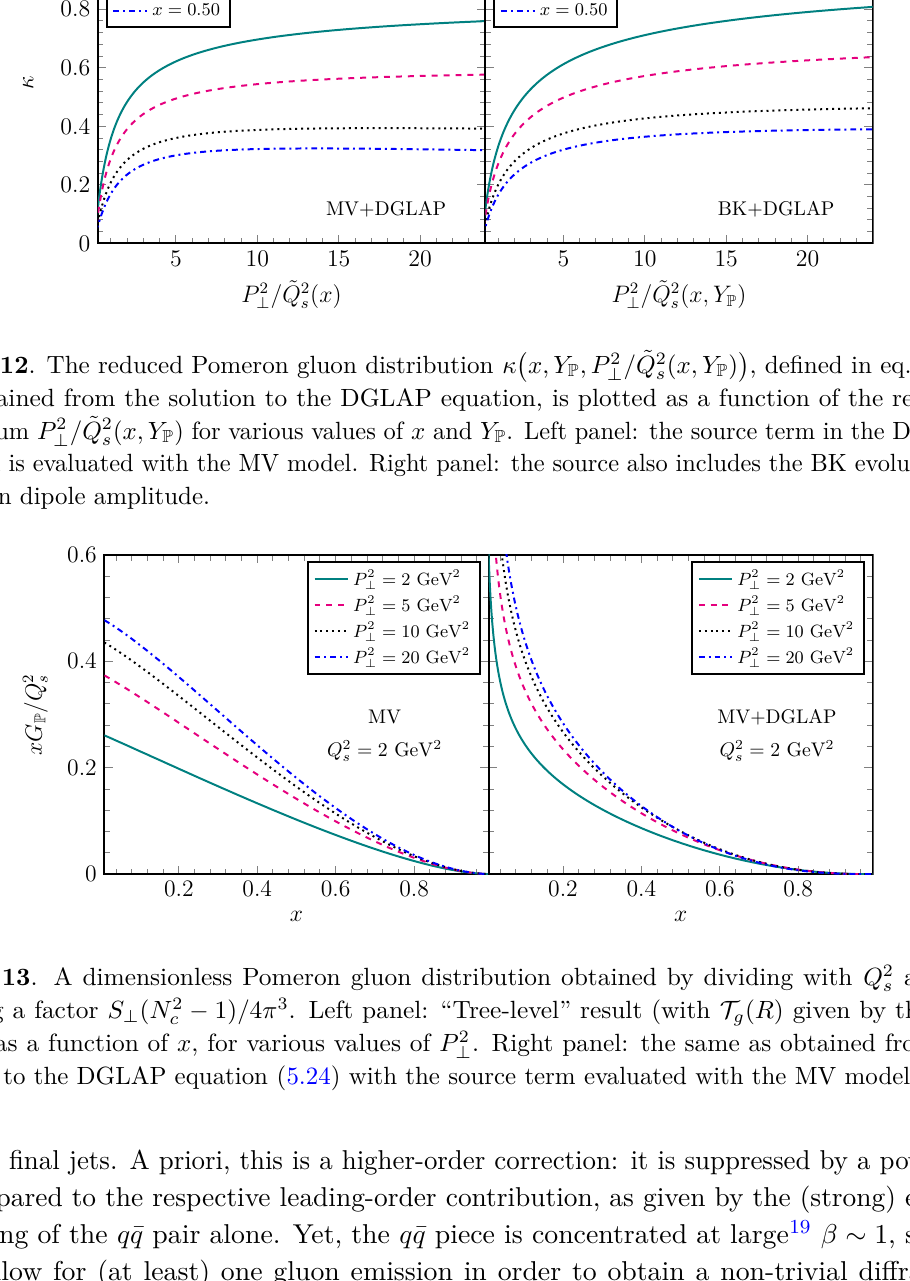
Figure 13 . A dimensionless Pomeron gluon distribution obtained by dividing with Q 2 and by s omitting a factor S ⊥ ( N 2 − 1) / 4 π 3 . Left panel: “Tree-level” result (with T g ( R ) given by the MV c model) as a function of x , for various values of P 2 . Right panel: the same as obtained from the ⊥ solution to the DGLAP equation (5.24) with the source term evaluated with the MV